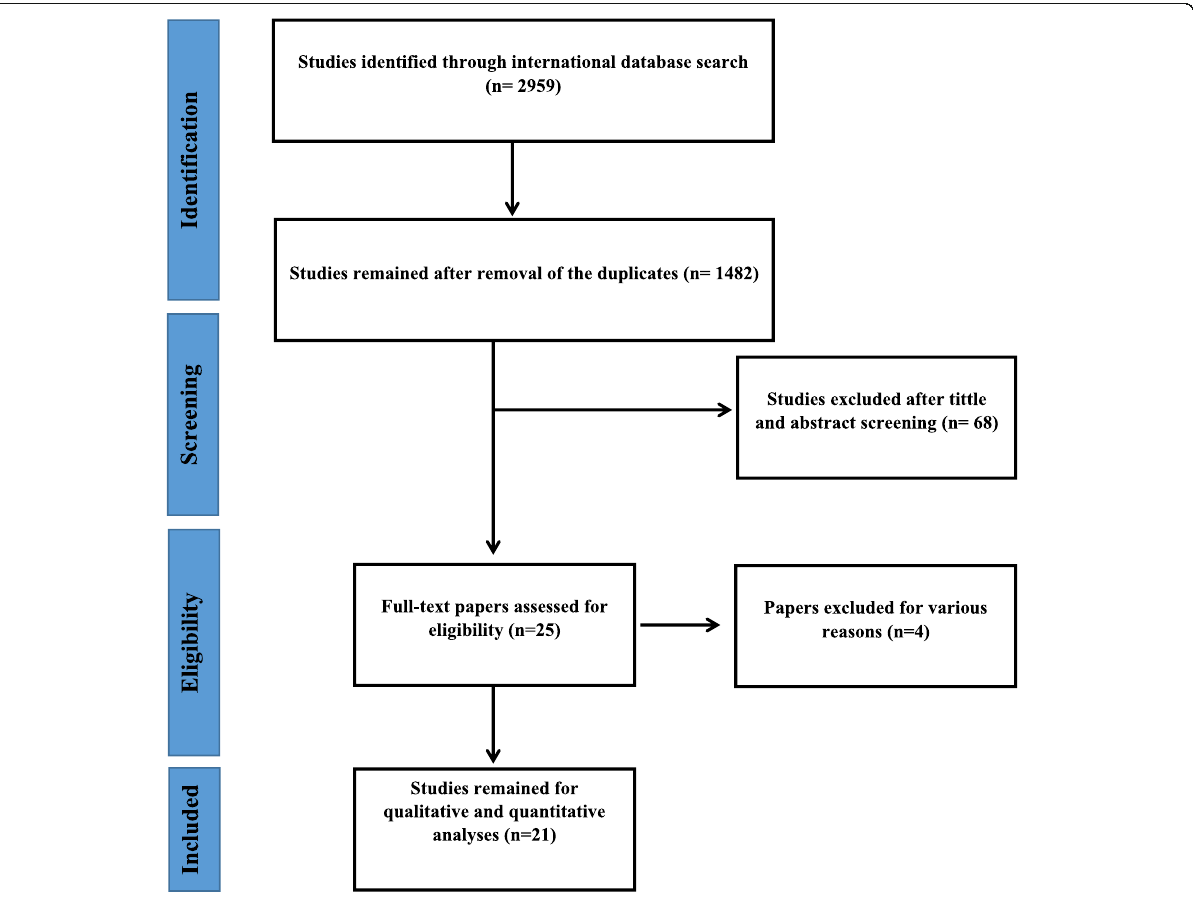
Fig. 1 Flowchart of the included eligible studies in a systematic